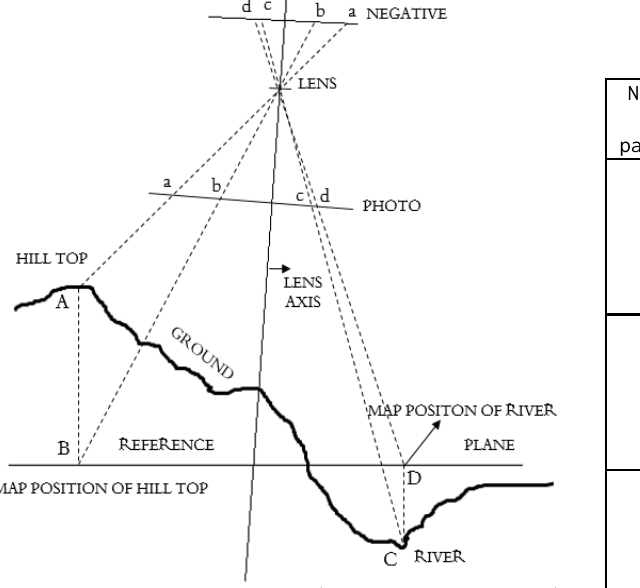
Figure 9. Relief displacement image (Sunita Devi, Veena, 2014) This displacement is different for different heights. On the other hand, the relationship between parallax and the height of features can be expressed in Equation 1.